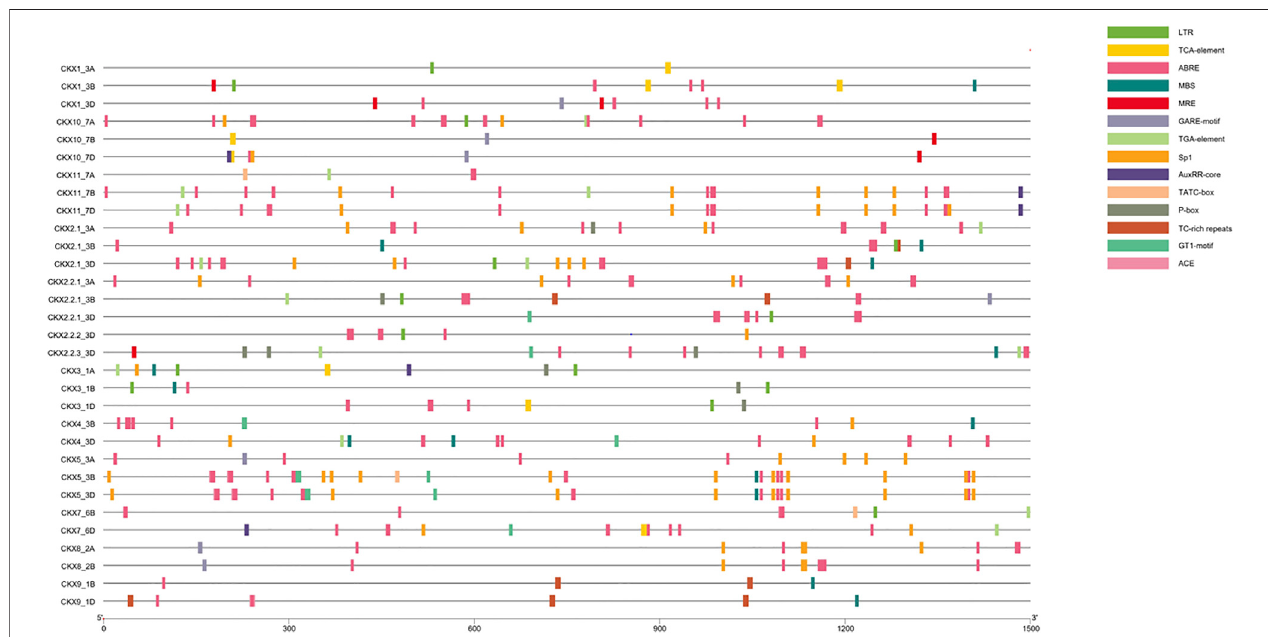
FIGURE 6 | Promoter analysis of CKX gene family in Triticum aestivum